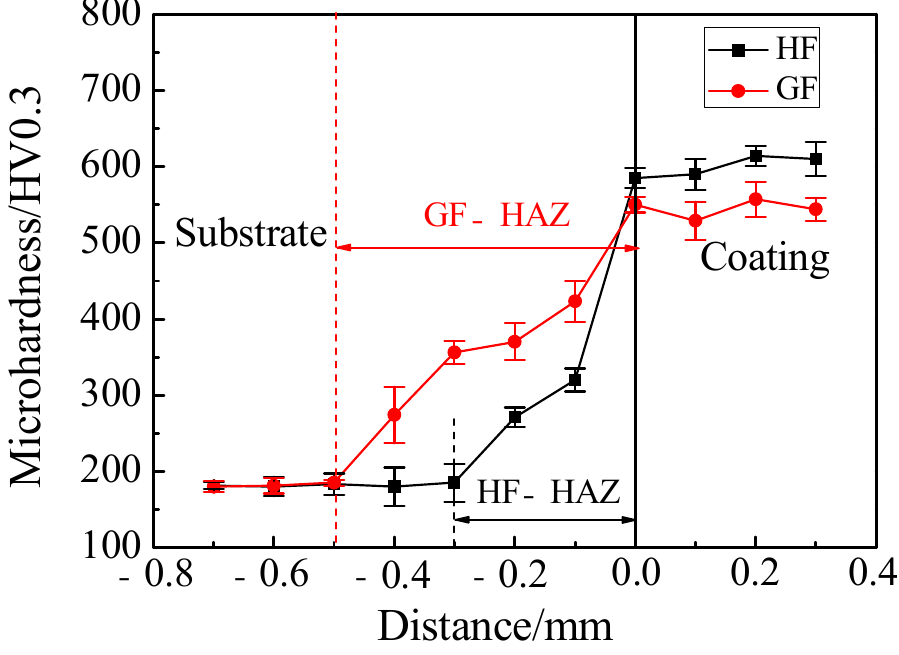
Figure 10. Microhardness curves of the GF and HF coating.